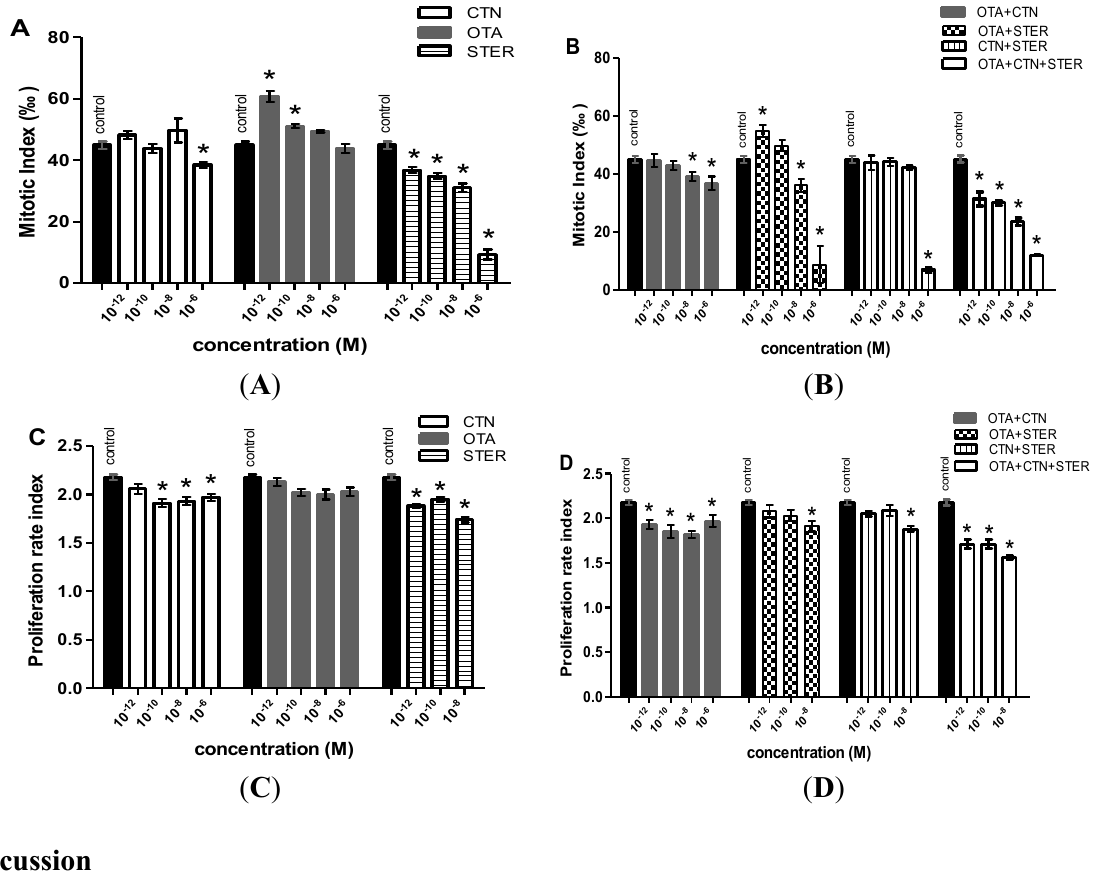
Figure 5. MI differentiation after ( A ) single CTN, OTA or STER administration, ( B ) CTN, OTA and STER co-administration. All treatments were tested in three independent experiments and approximately 12,000 nuclei were scored for each treatment. PRI differentiation after ( C ) single CTN, OTA or STER administration, ( D ) CTN, OTA and STER co-administration. All treatments were tested in three independent experiments and approximately 500–600 metaphases were scored for each treatment. STER and STER-co-treatments at 10 −6 M were highly cytotoxic. Bars represent mean ± SEM. The asterisks indicate statistically significant differences over the respective vehicle-treated cells ( p <